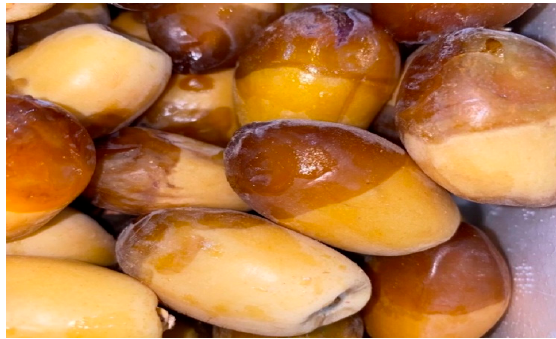
Figure 17. Sample of Al-muraaya dates.